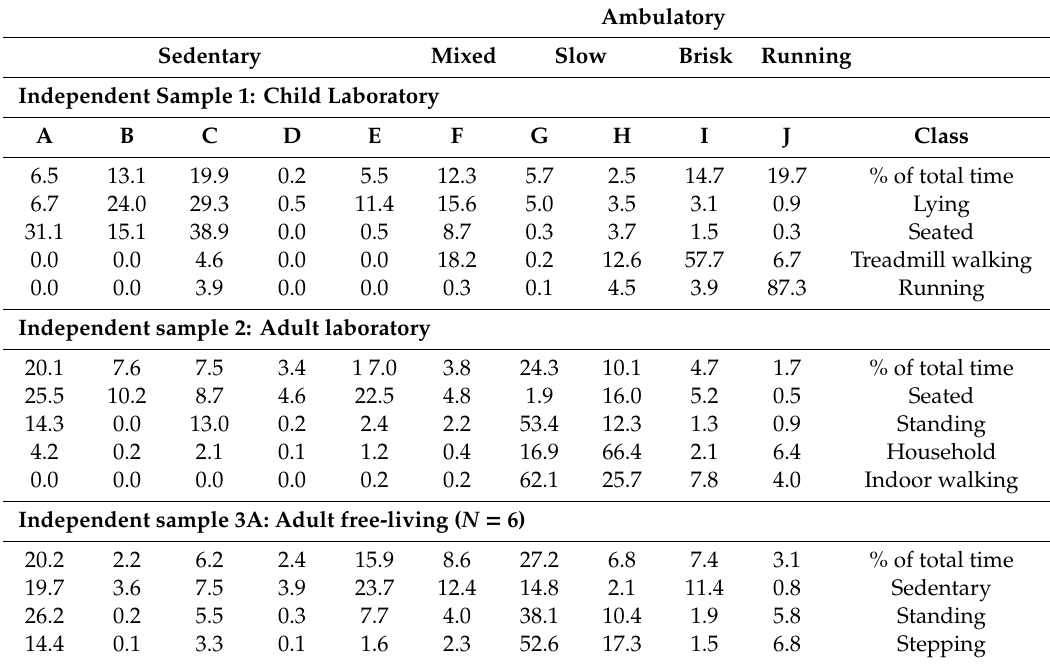
Table 4. Purity matrices for independent datasets 1 to 3 (percentage of each class found within each cluster (A–J).